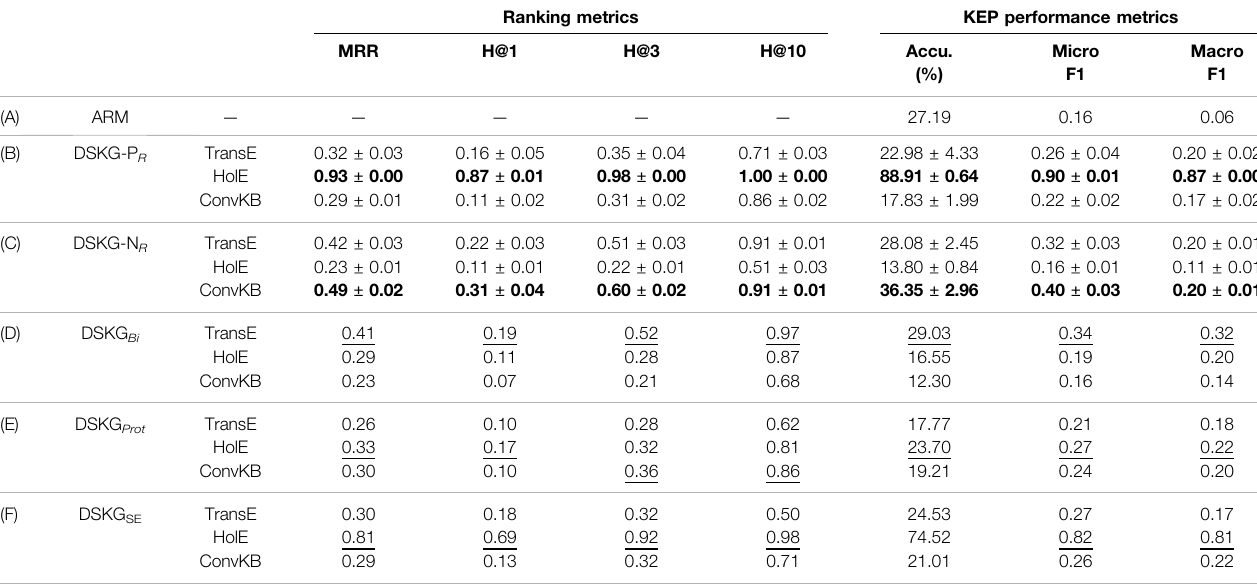
TABLE 5 | KEP results of association rule mining (ARM) baseline (A), DSKG R generated using Pandaset (DSKG-P R ) and NuScenes (DSKG-N R ) on three algorithms, each experimentaveragedwithstandarddeviationacross fi